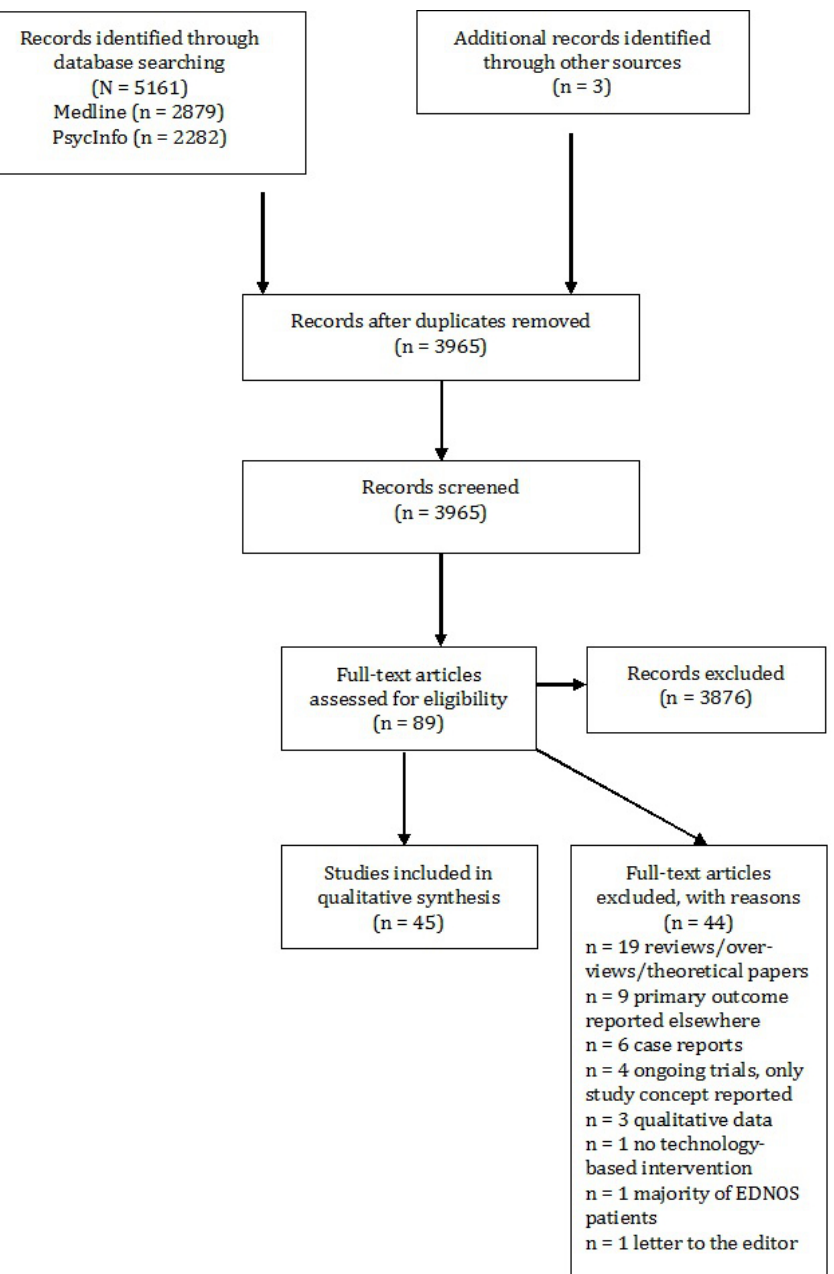
Figure 1. PRISMA flow chart of the literature